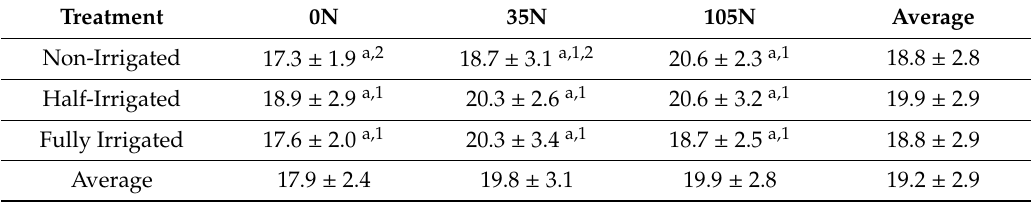
Table 14. The e ff ect of di ff erent fertilization rates on 100-seed weight (g) of soybean (cv. Pannonia Kincse) under di ff erent irrigation regimes, averaged among 2017, 2018, and 2019 in Debrecen, Hungary.